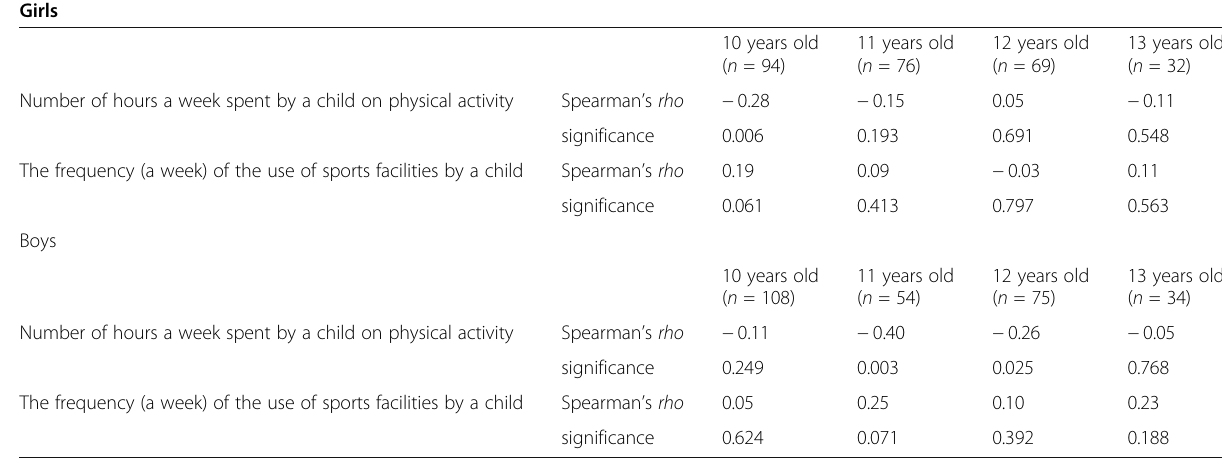
Table 12 The correlation between BMI and a number of hours spent by a child on physical activity and the frequency (a week) of the use of sports facilities by a child depending on age and sex Girls